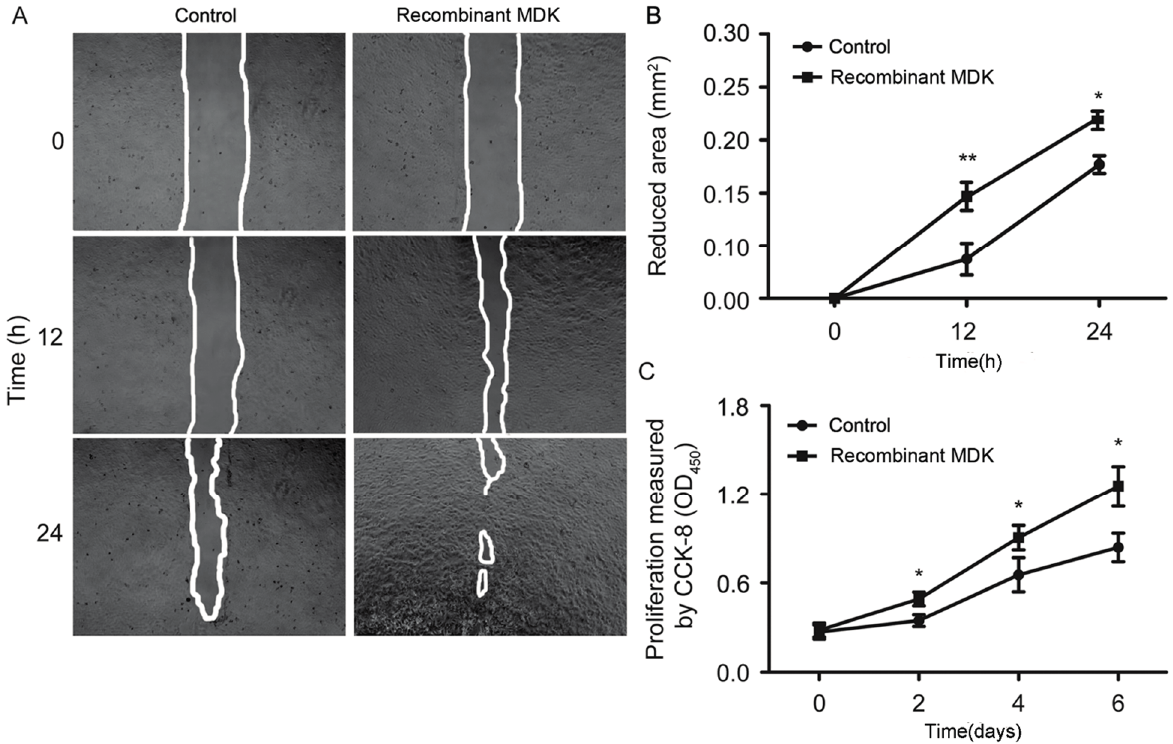
Figure 5. Recombinant MDK (Midkine) promotes LGE (Lacrimal gland epithelial) cell migration and proliferation. ( A ) Images of LGE cell scratch-wound healing assays. Scale bar = 250 µm; ( B ) Quantification of the reduced area; N = 5. The values are the means ± SEM. * p < 0.05, ** p < 0.01; ( C ) In vitro proliferation assay for LGE cells treated with MDK; N = 5. The values are the means ± SEM. * p <